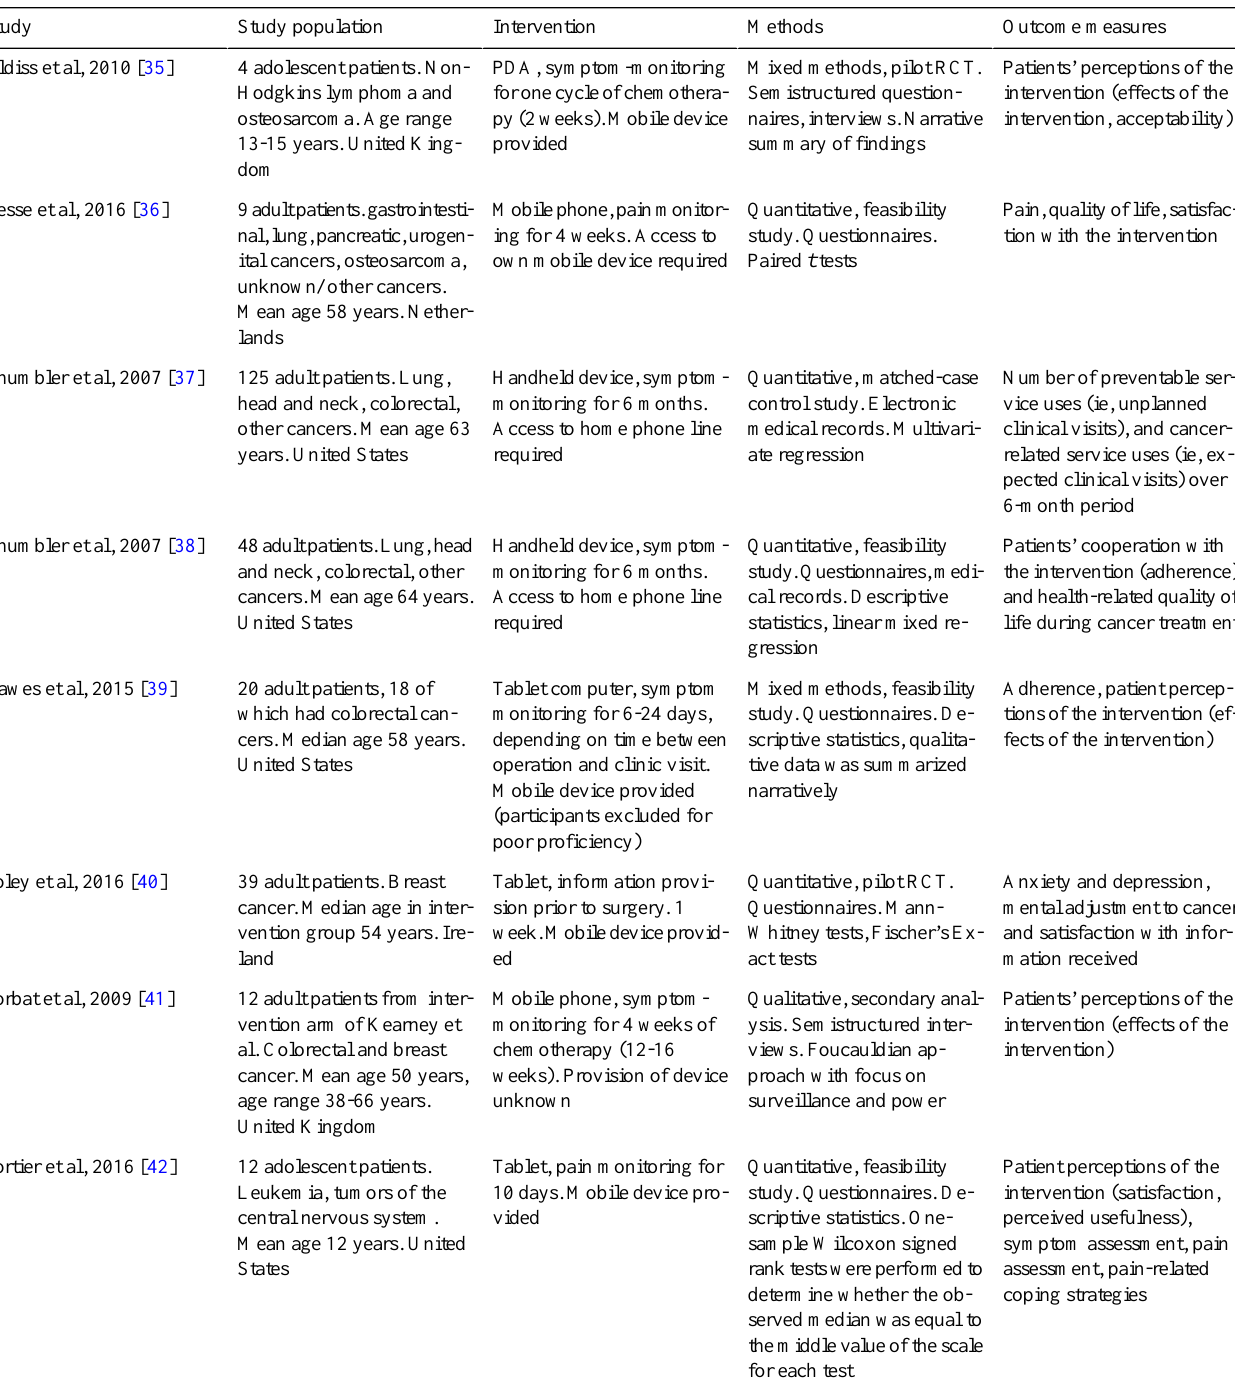
Table 1. Characteristics of included